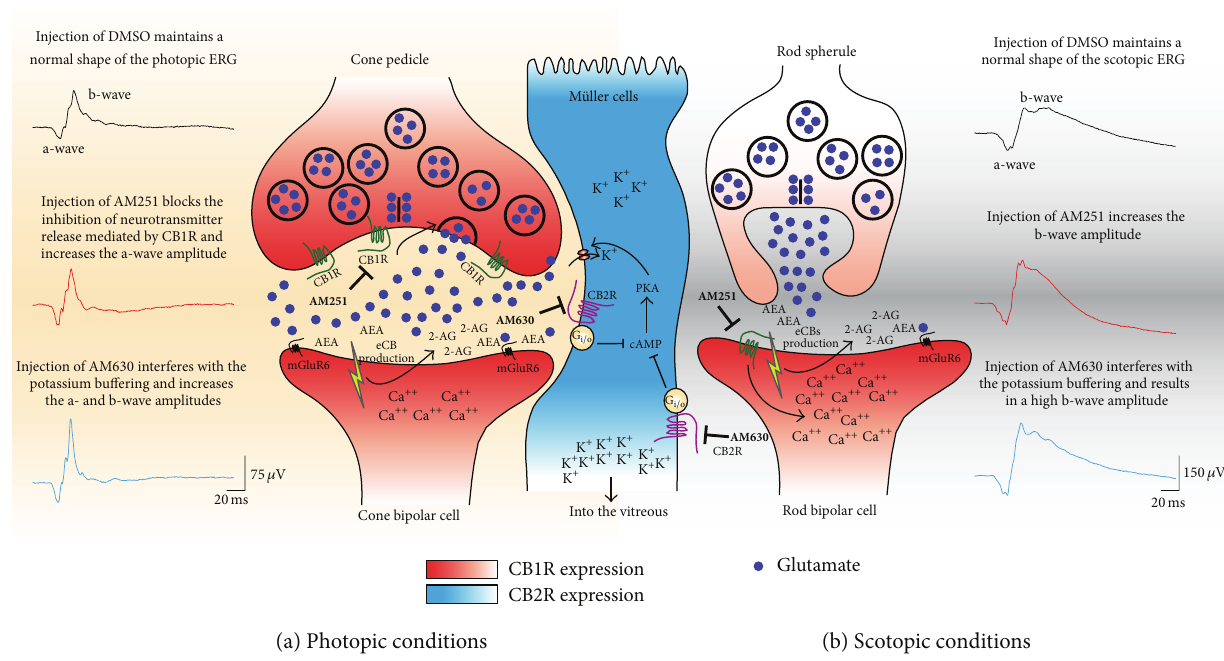
Figure 8: Schematic illustration of the proposed mechanisms underlying the actions of AM251 and AM630 in the monkey retina, as revealed by electroretinography under photopic (a) and scotopic (b) conditions. (See Discussion for details.)